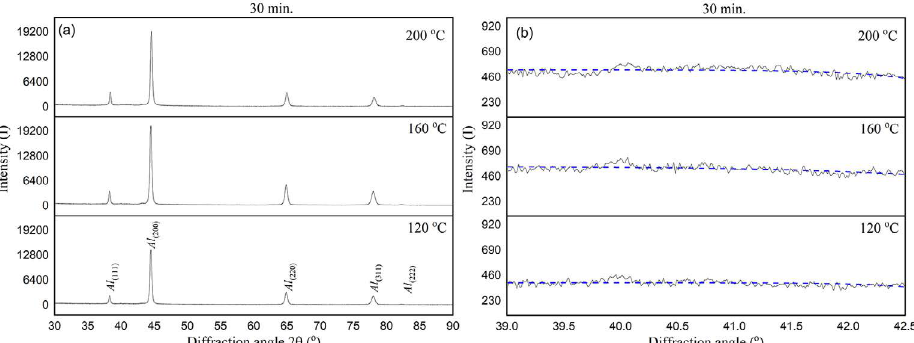
Figure 3. XRD results from samples aged for 30 minutes at different aging temperatures, a) Peaks obtained between 30- 90º scanning angles from specimens aged for 30 minutes. (Upper graphic is for aging at 200 ºC. Graphic centered is at 160 ºC. Lower graphic is at 120 ºC), b) Zoomed image (39- 42.5 scanning angles)